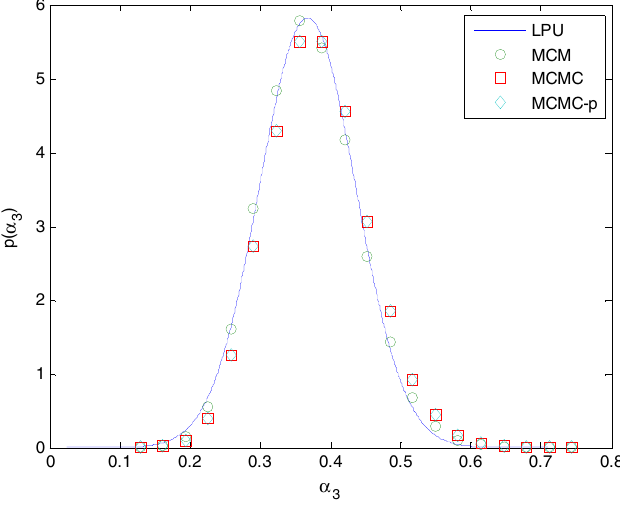
Fig. 1. Four distributions associated with the parameter α 1 .